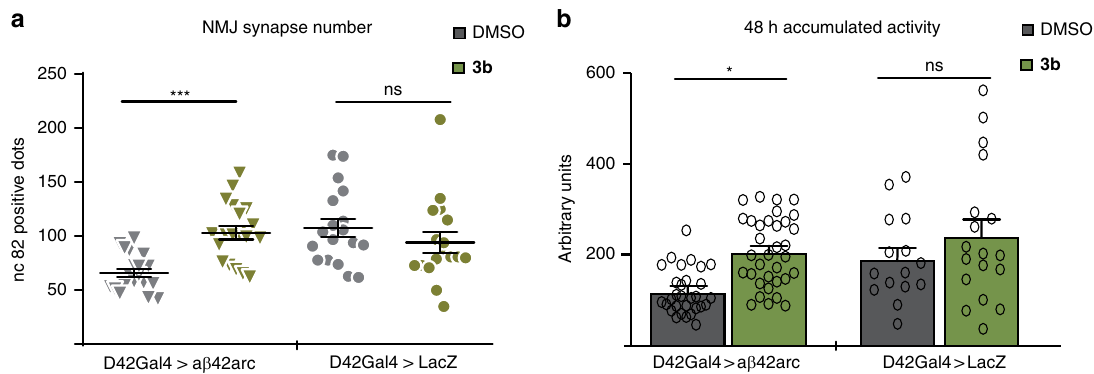
Fig. 9 In vivo effects of compound 3b . Flies with motoneuron overexpression of the human a β 42arc (arctic mutation) (D42Gal4 > a β 42arc) or mock expression (D42Gal4> LacZ) were fed with 3b (100 μ M) or same volume of vehicle DMSO. a Twenty-day old adult abdominal motoneurons were analyzed and synapse number (nc82-positive spots) of the same motoneuron in different fl ies (16 – 19) were determined using Imaris, over the confocal 1 µ m stacks. Data are plotted in graphs, where each grey triangle (a β 42arc fl ies fed with vehicle) and green triangle (a β 42arc fl ies fed with 3b ) or each grey circle (control fl ies fed with vehicle) and green circle (control fl ies fed with 3b ) represents one value. Horizontal line represents mean ± SEM. Data are analyzed statistically with unpaired two-tailored Student ’ s t test; *** P < 0.001. b Locomotor activity of individual 15 days old fl ies was recorded for 4 days in Drosophila Activity Monitors (DAM2, Trikinetics) 36 , the total number of beam breaks per hour during two consecutive days was analyzed (the activity